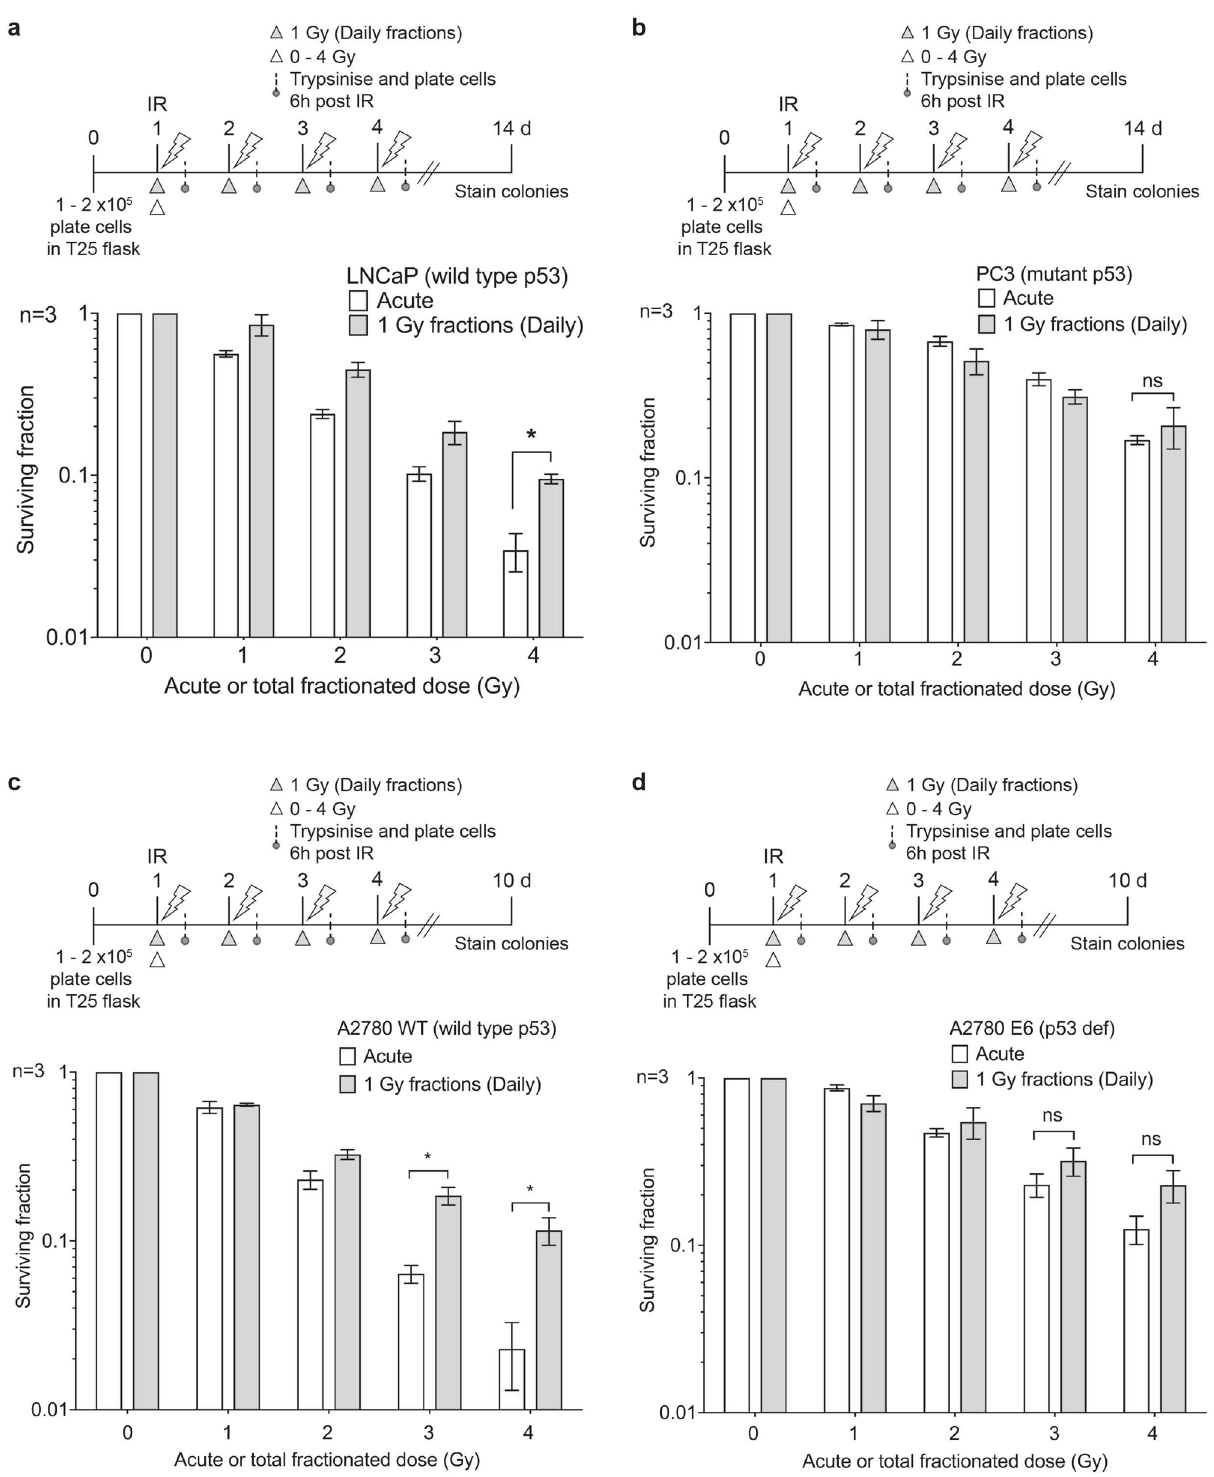
Figure 4. Split-dose recovery is lost in tumour cell lines with mutant p53. Colony survival of tumour cell lines ( a ) LNCaP ( b ) PC3 ( c ) A2780 WT and ( d ) A2780 E6 after exposure to either acute or daily fractionated IR with indicated doses. Top panel in each histogram shows the experimental schema, white triangle represents single acute dose and grey triangle 1 Gy daily fractions. Post radiation (6 h) cells were trypsinised and pooled with cells collected from media, plated and allowed to form colonies. Significant increase in split-dose recovery is observed in p53 WT tumour cell lines, LNCaP and A2780 WT ( a , c ) but not in mut p53 cell lines, PC3 and A2780 E6 ( b , d